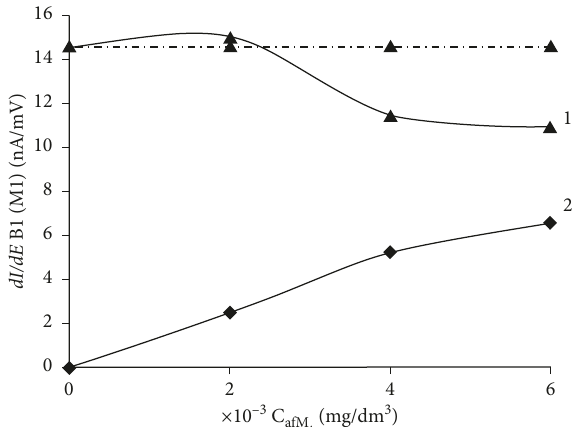
N 1 and 1 peak on the accumulation potential of the GCE. The � 2 × 10 − 3 mg/dm 3 ; (2) C � 2 × 10 − 4 mg/dm 3 . afM 1 afM 1